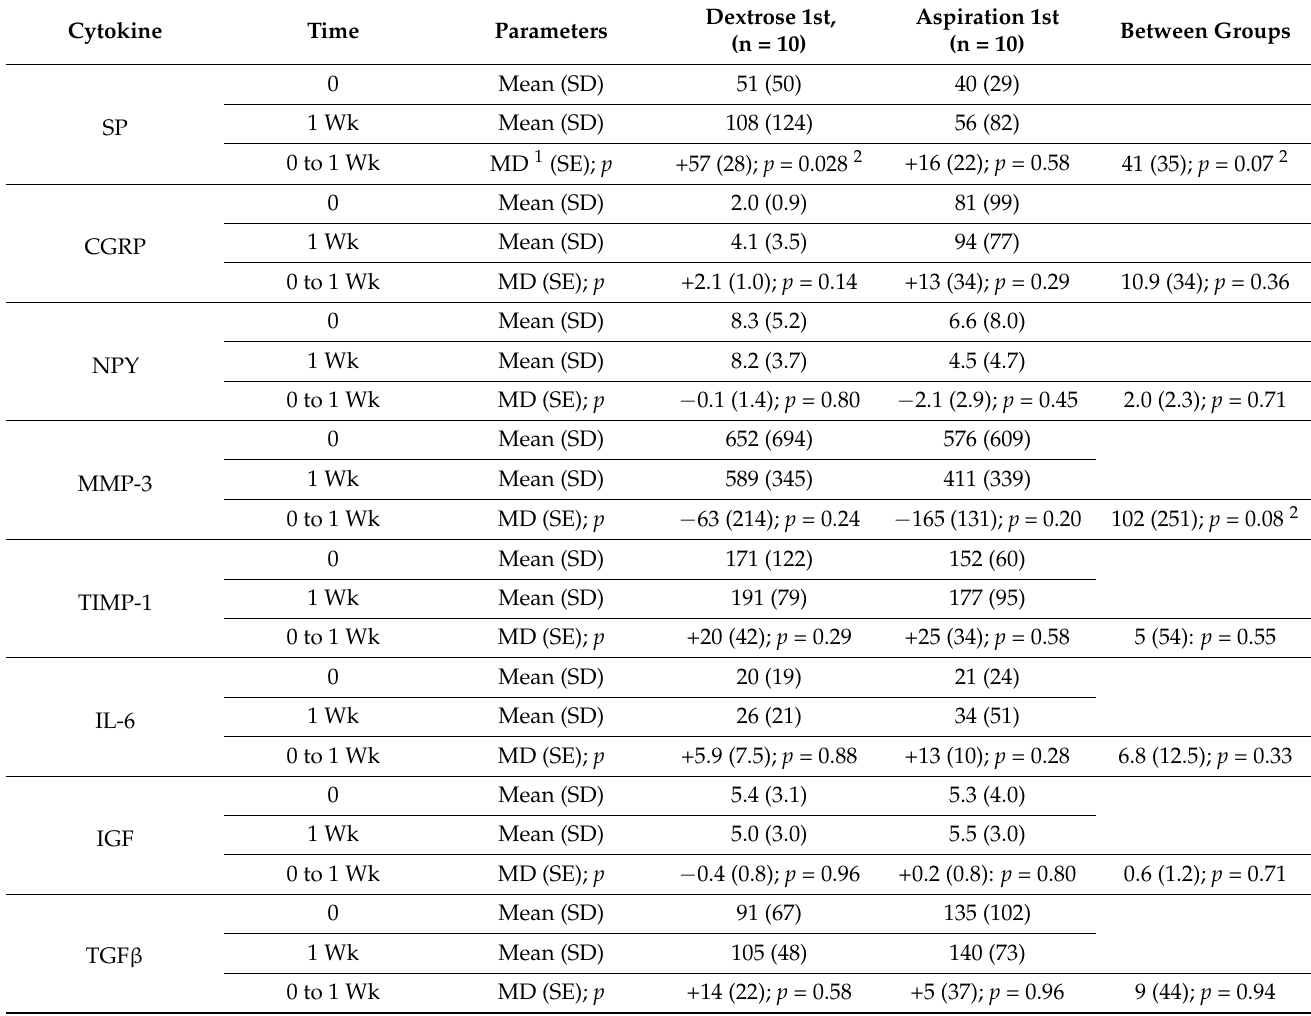
Table 3. Time 0-week and 1-week cytokine concentrations in picograms/mL, adjusted for total protein